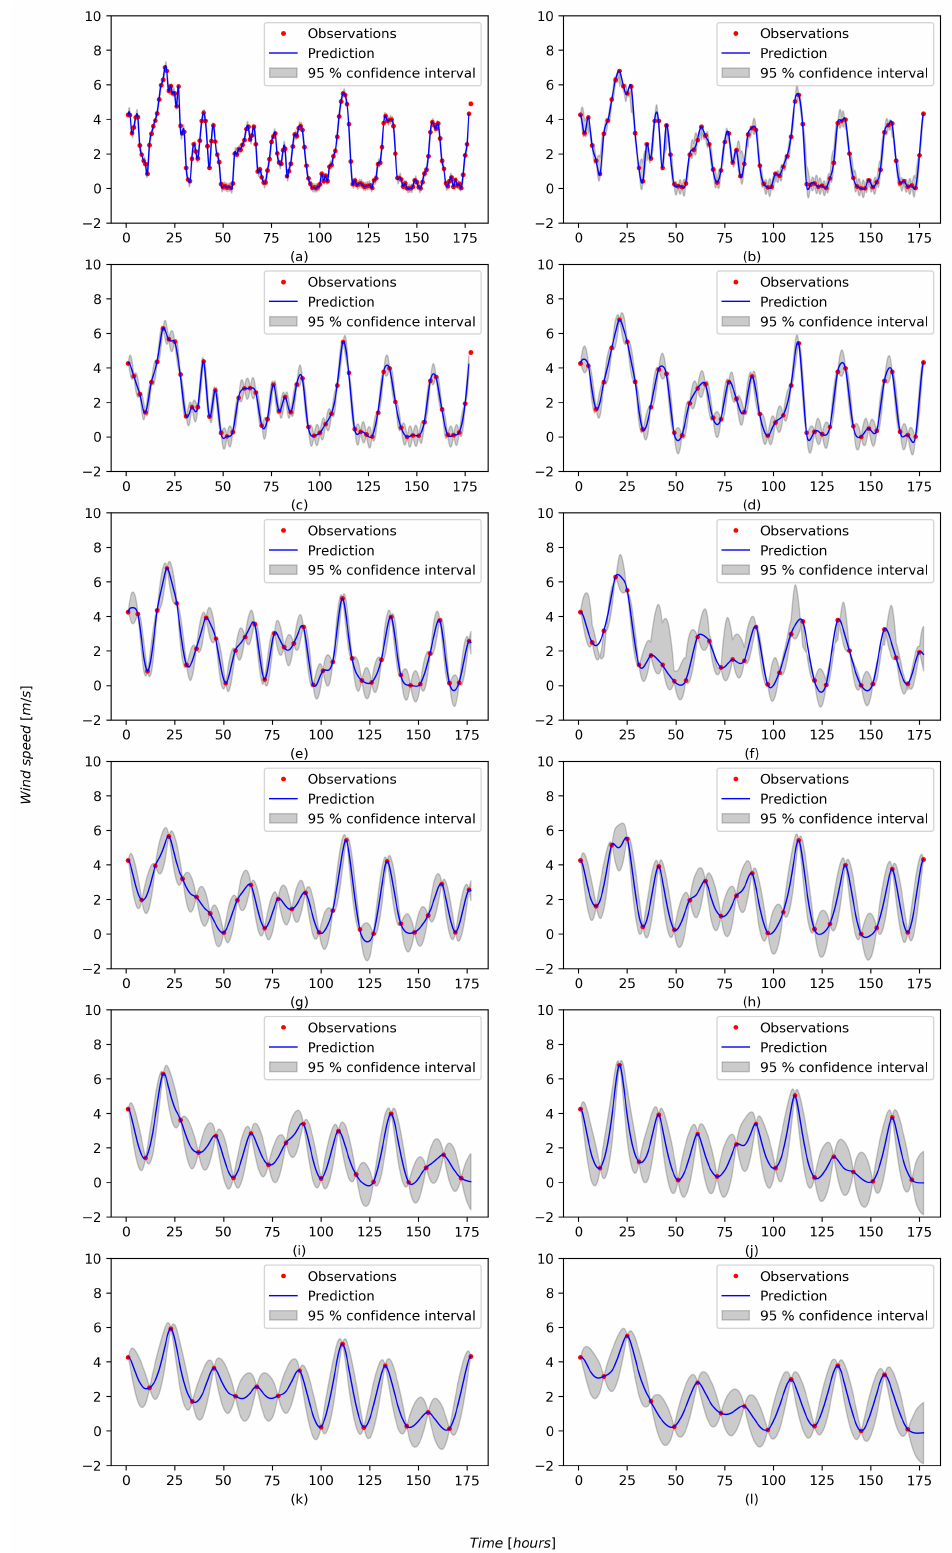
Figure 5. Applying Gaussian process regression to interval deficient wind speed data. The wind speed data was sampled every ( a ) 1 h, ( b ) 2 h, ( c ) 3 h, ( d ) 4 h, ( e ) 5 h, ( f ) 6 h,s ( g ) 7 h, ( h ) 8 h, ( i ) 9 h, ( j ) 10 h, ( k ) 11 h and ( l ) 12